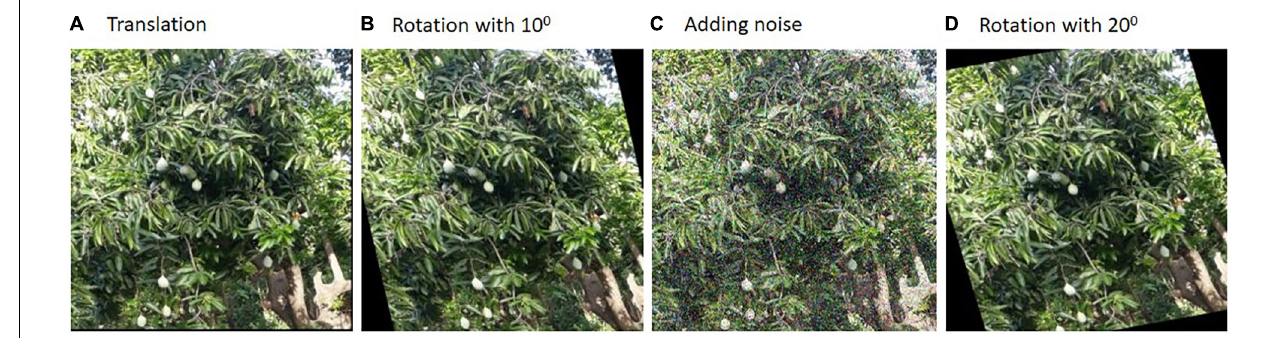
FIGURE 4 | Random transformations intended for data augmentation.